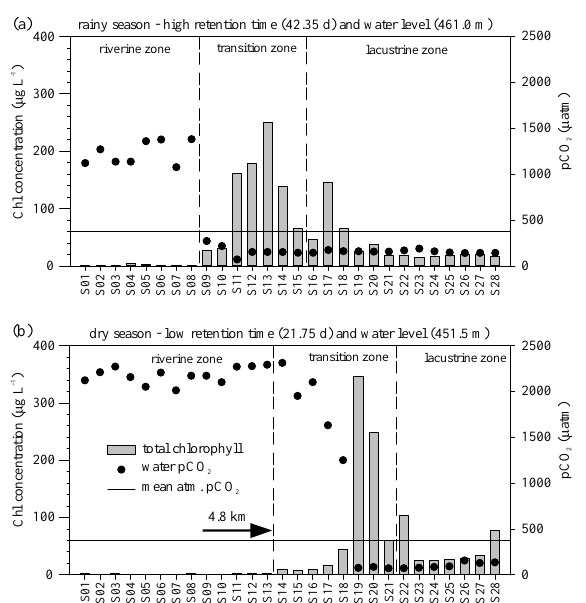
Figure 3. Lotic–lentic gradient of p CO 2 and Chl at the 28 sam- pling stations in the main reservoir body during the rainy season (a) and dry season (b) . The water level was 461.0 and 451.5m during the rainy season and dry season, respectively. Three zones can be clearly defined (riverine, transition and lacustrine zones). The arrow shows that the transition zone starts 4.8km down-reservoir during a period of low water